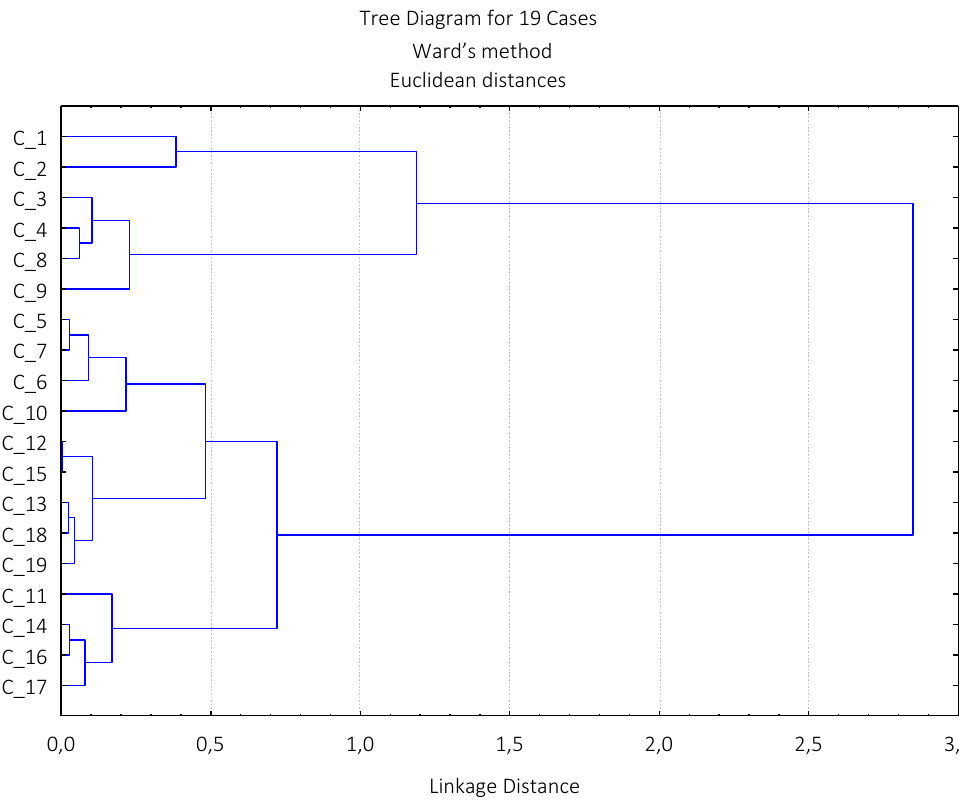
Figure 1. Dendrogram by complex indicators illustrating the competitive capacity level by financial indicators and the digital transformation level Table 4. Characteristics of bank clusters by the level of competitive capacity